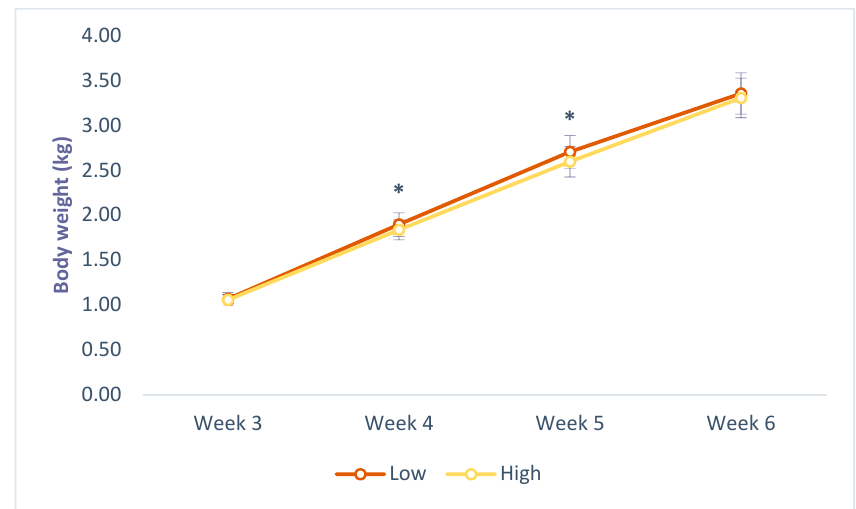
Figure 7. Effects of outdoor access on body weight of commercial-line broilers. * Indicates statistically significant differences (Tukey’s HSD test; p ≤ 0.05).